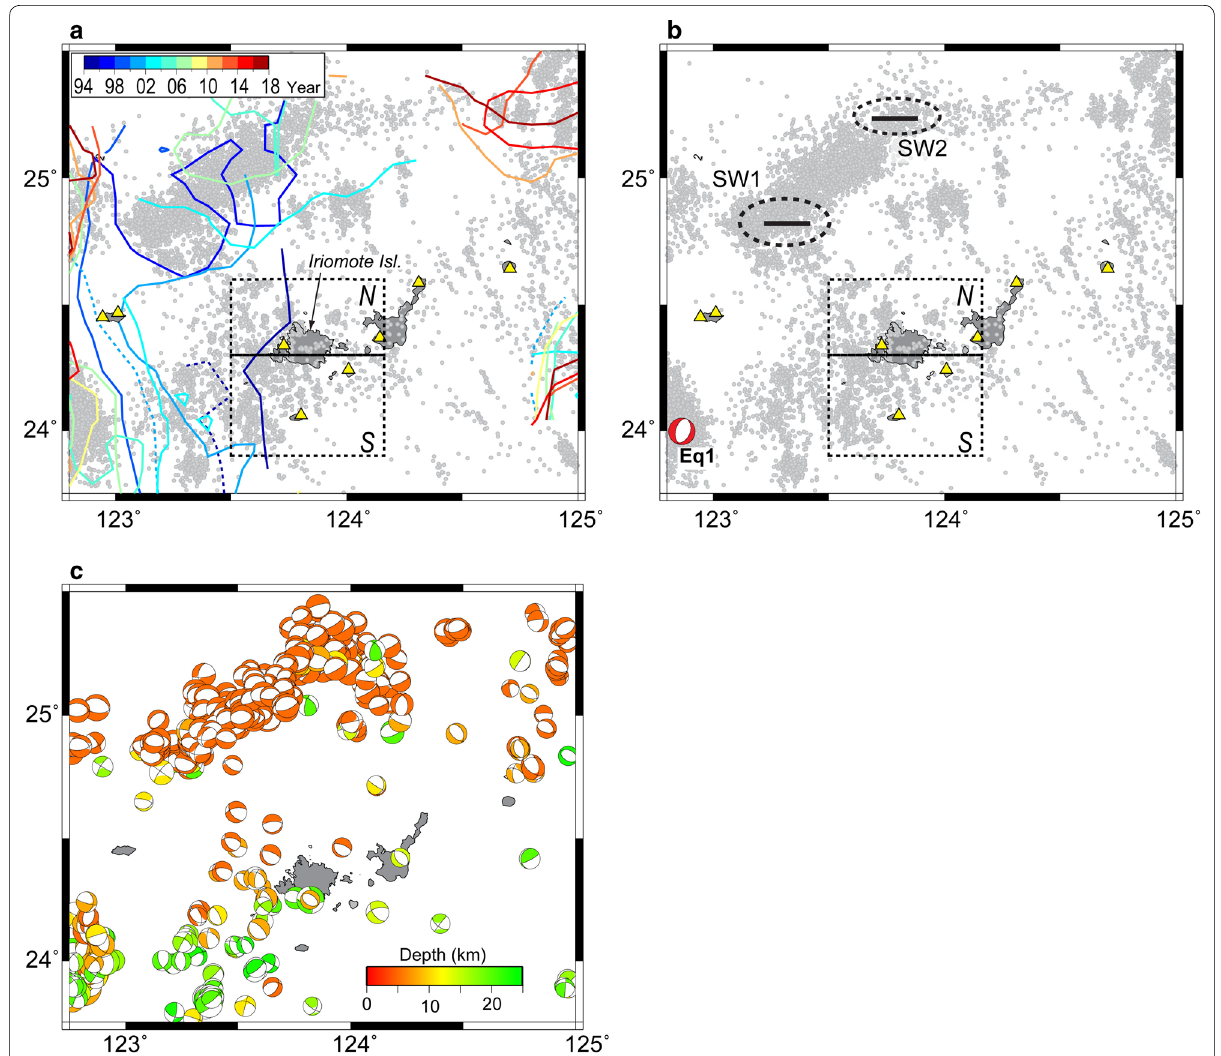
Fig. 2 Epicenter distribution of earthquakes from January 1994 to December 2017 for those with depths shallower than 30 km and magnitudes over 2.0. a Magnitude completeness. The solid lines show the contours where the magnitude completeness was 2.0. The dotted lines show the contours of 1994–1995 and 2000–2001 where the magnitude completeness was 2.3. The lines are colored corresponding to the initial year for the period in which the Mc was calculated. Yellow triangles show the JMA seismic stations. b Locations of earthquake swarms and large earthquakes. Dotted rectangles show the areas where the cumulative number of earthquakes is plotted in Fig. 3. The CMT solution shows the event of Eq1 (Fnet, NIED). c The CMT solutions of the earthquakes (between January 2000 and March 2018) whose depths are shallower than 20 km. The CMT solutions of Fnet provided by NIED were